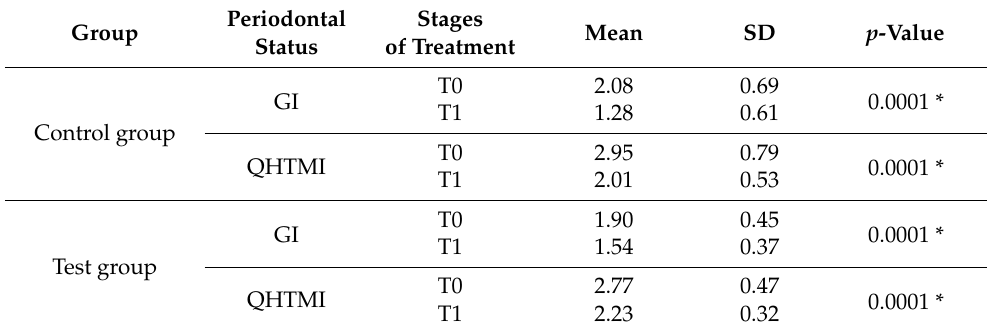
Table 2. Comparison of periodontal status at T0 and T1 stages of the treatment between two groups. Stages Periodontal Groups Mean SD p -Value of Treatment Status Control group 1.91 0.45 GI Test group 2.08 0.69 T0 Control group 2.77 0.48 QHTMI Test group 2.95 0.79 Control group 1.54 0.37 GI Test group 1.29 0.61 T1 Control group 2.22 0.32 QHTMI Test group 2.01 0.53